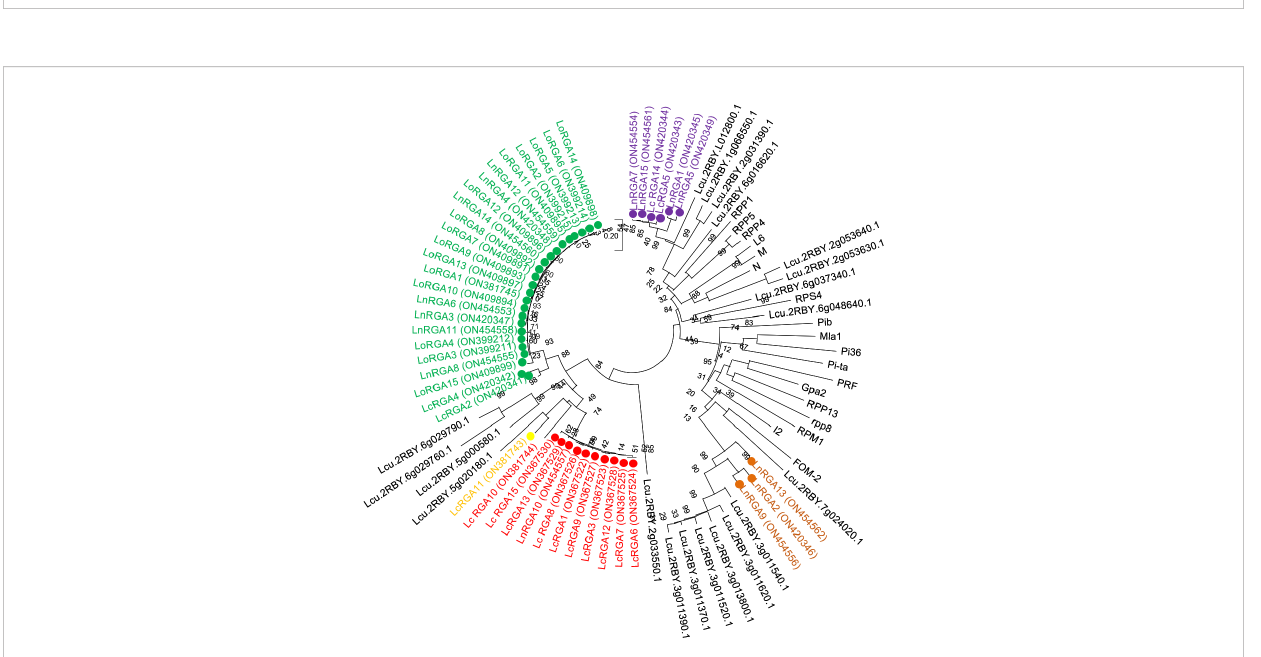
FIGURE 7 Neighbor-joining phylogenetic tree constructed based on isolated lentil RGAs, lentil R gene, and known NBS region of R genes N (U15605), L6 (U27081), M (U73916), RPP5 (AAFO8790.1), RPP4 (AAM18462.1), RPP1 (AT3444670), RPS4 (CAB50708.1), Mla (AAG37356), Pi-ta (ACY24970.1), Pi36 (ADF29629.1), Pib (BAA76282.2), I2 (AF004878), RPP13 (AAF42831), RPM1 (AQ39214), Prf (U65391), Gpa2 (AF195939), RPP8 (AAC78631.1.), and FOM-2 (AY583855.1) at bootstrap values (1000 replicates). Numbers on the branches indicate the percentage of bootstrap replications. Green represents LRGA 1, blue represents LRGA 2, yellow represents LRGA 3, red represents LRGA 4, purple represents LRGA 5, and orange represents LRGA